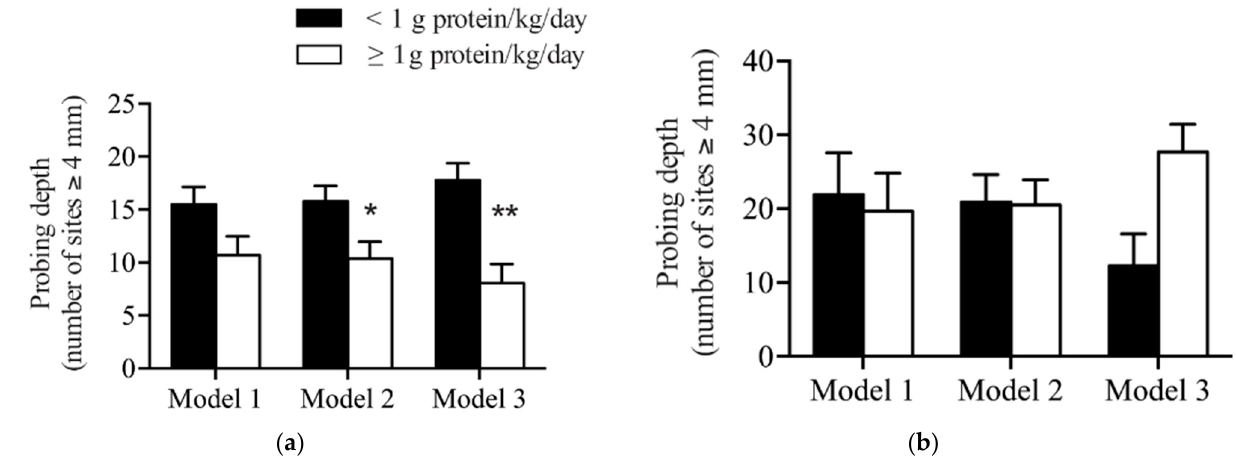
Figure 2. Comparison of dietary protein levels with probing depth after non-surgical periodontal therapy in patients who ( a ) did not smoke and ( b ) did smoke. Model 1 is unadjusted. Model 2 adjusted for baseline probing depth, hygienist and time between treatment and follow-up. Model 3 adjusted for variables in Model 2 plus age, sex, BMI, flossing frequency and bleeding on probing. Data presented are estimated marginal means ± SEM. * Indicates a significant difference between groups ( p < 0.05), ** indicates a significant difference between the two levels of protein intake ( p < 0.01).